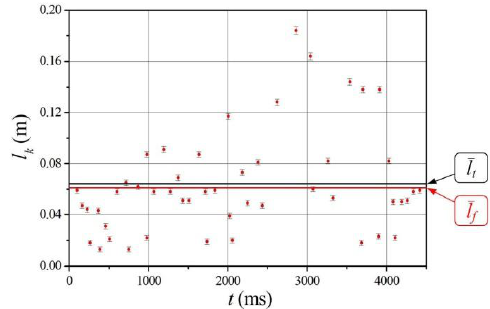
Fig. 7. Distribution of bubbles cluster length l k